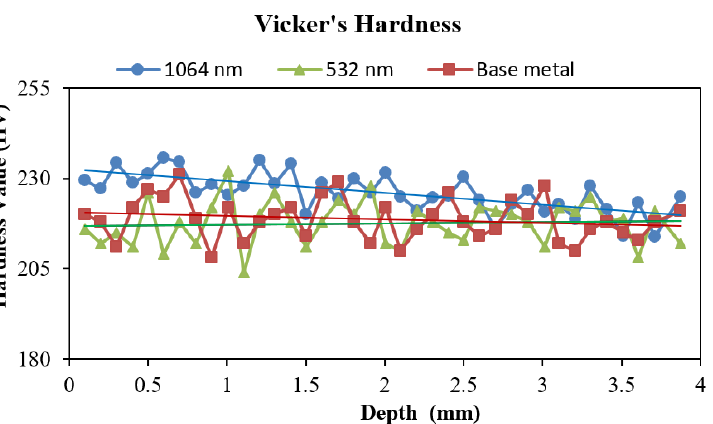
Figure 9. Grain boundary misorientation distribution in the subsurface region of microalloyed steel specimen ( a ) in unpeened condition; after LSP at 1064 nm with ( b ) 3 GW/cm 2 , ( c ) 6 GW/cm 2 , ( d ) 9 GW/cm 2 , and ( e ) 12 GW/cm 2 ; and after LSP at 532 nm with ( f ) 3 GW/cm 2 , ( g ) 6 GW/cm 2 , and ( h ) 9 GW/cm 2 .